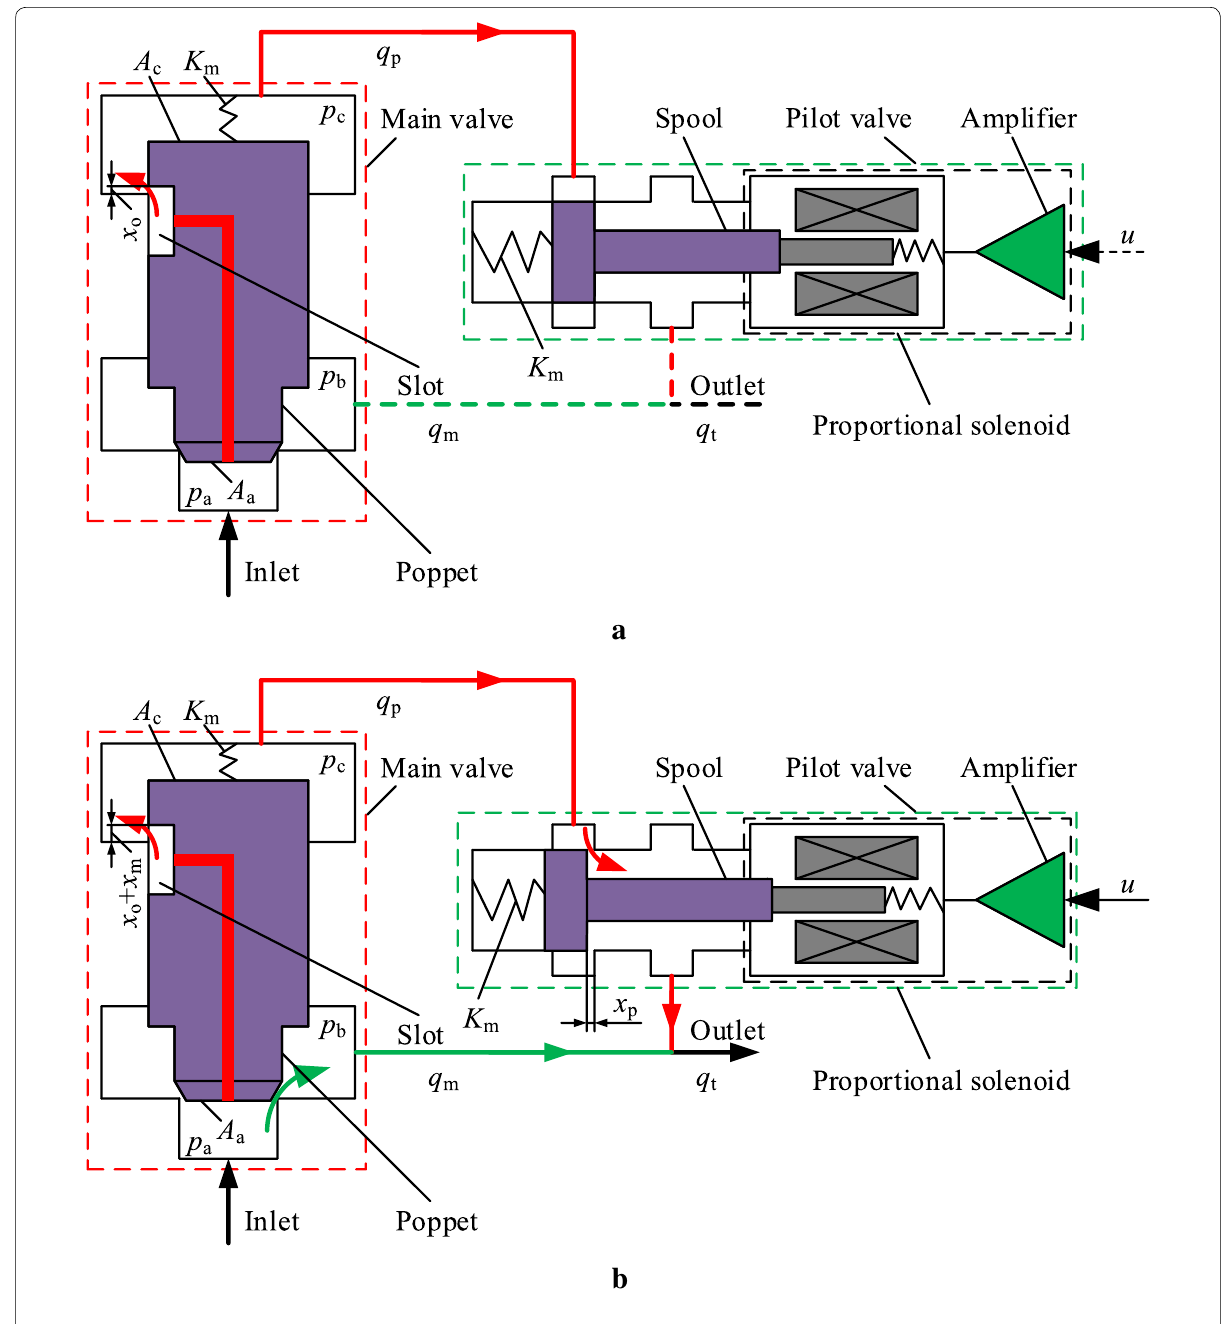
Figure 1 Schematic diagram of the Valvistor valve: a No voltage signal input, and b voltage signal